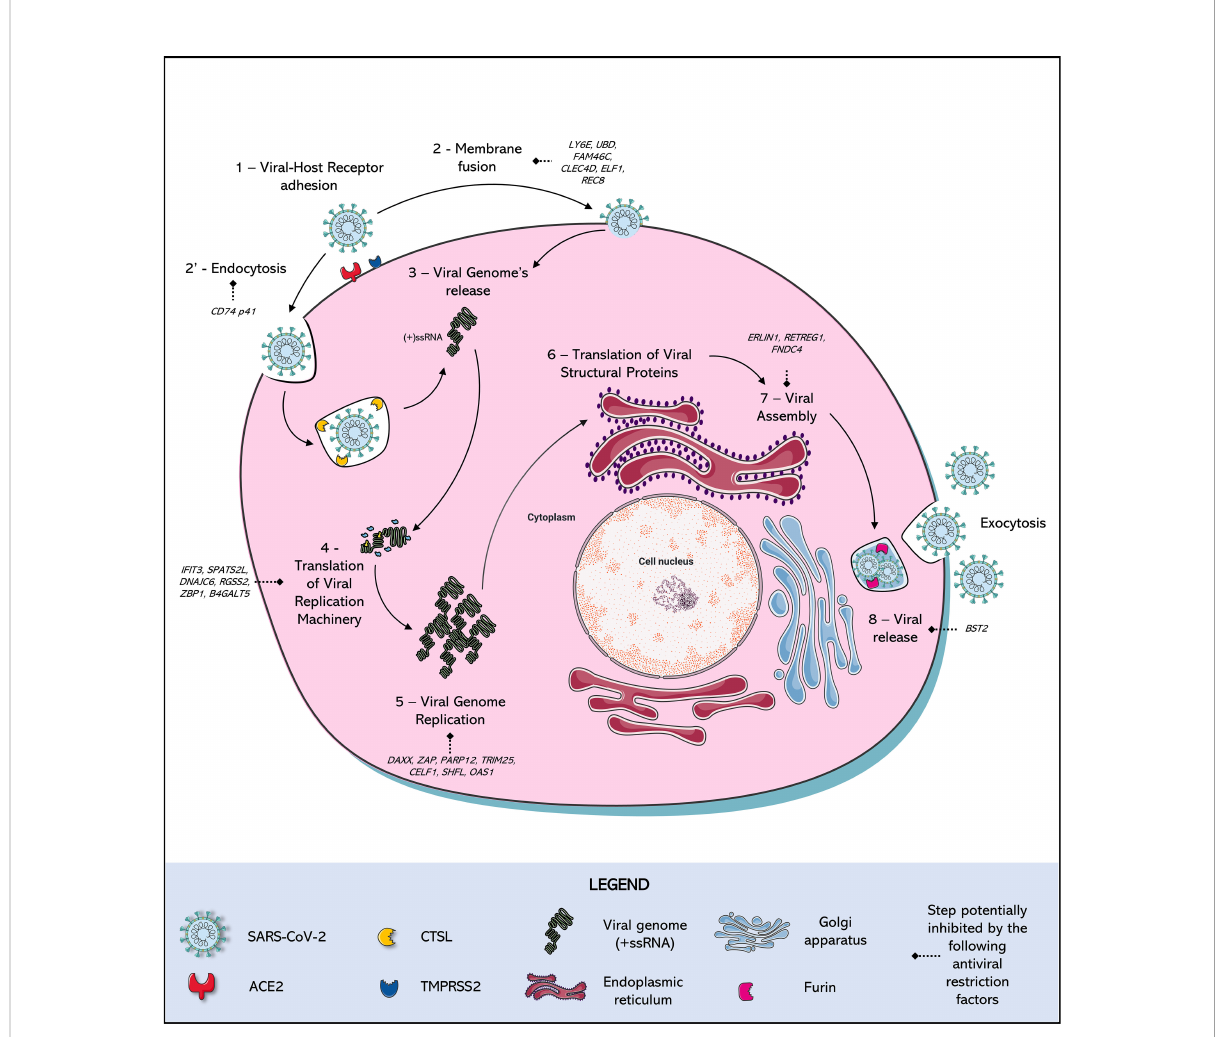
FIGURE 1 SARS-Cov-2 Replication Cycle and antiviral restriction factors in each step of viral replication. (1) Adhesion: SARS-CoV-2 Spike (S) protein binds to a cellular receptor, which is mostly Angiotensin-Converting Enzyme 2 (ACE2), although alternative receptors are described (Ex: ASGR1, KREMEN1). (2) Entry: When there is expression of transmembrane protease serine 2 (TMPRSS2), this protease cleaves the viral Spike protein mediating entry by fusion of the viral membrane to the host cell membrane. In parallel, in the absence of expression of this protease, entry occurs by (2 ’ ) endocytosis mediated by the receptor, triggering the formation of endo-lysosomes in which Cathepsin L (CTSL) will be responsible for the cleavage of the Spike protein. A new conformational arrangement is induced by this cleavage, triggering (3) the viral genome (+ssRNA) release (via uncoating) into the cell cytoplasm. After the viral RNA is delivered into the host cell, the (4) translation of the viral replication machinery begins: the coronavirus genomic RNA encodes nonstructural proteins (NSPs) that have a critical role in (5) Viral Genome replication: process in which the virus induces the synthesis its RNA, mediated by NSPs. (6) Translation of Viral Structural Protein: the structural proteins S, Envelope (E), and Membrane (M) are translated by ribosomes that are bound to the endoplasmic reticulum (ER). The nucleocapsid proteins (N) remain in the cytoplasm and are assembled from genomic RNA. They fuse with the precursor virion, which is then transported from the ER through the Golgi Apparatus. The Spike cleavage at the S1/S2 furin site probably takes place when virions are released through the Golgi apparatus, responsible for the (7) Viral release: transporting virions to the cell surface via small vesicles, fi nally released by (8) Exocytosis: the viral progeny is released by exocytosis to the extracellular medium, ready to fi nd and infect new cells. Many of these steps are antagonized by intact cell defense mechanisms, known as restriction factors, which stop viral replication in response to